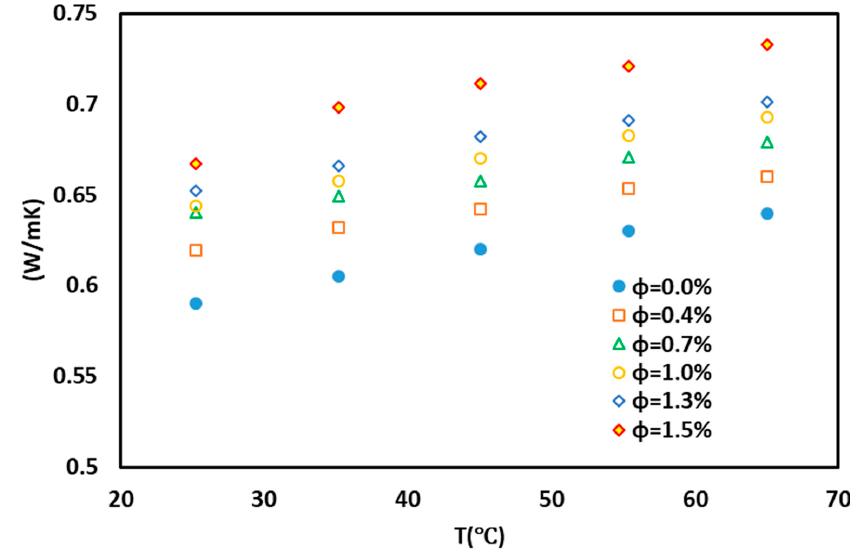
Figure 5. Variations in thermal conductivity coefficient of nanofluid with temperature and concentration of nanoparticles.